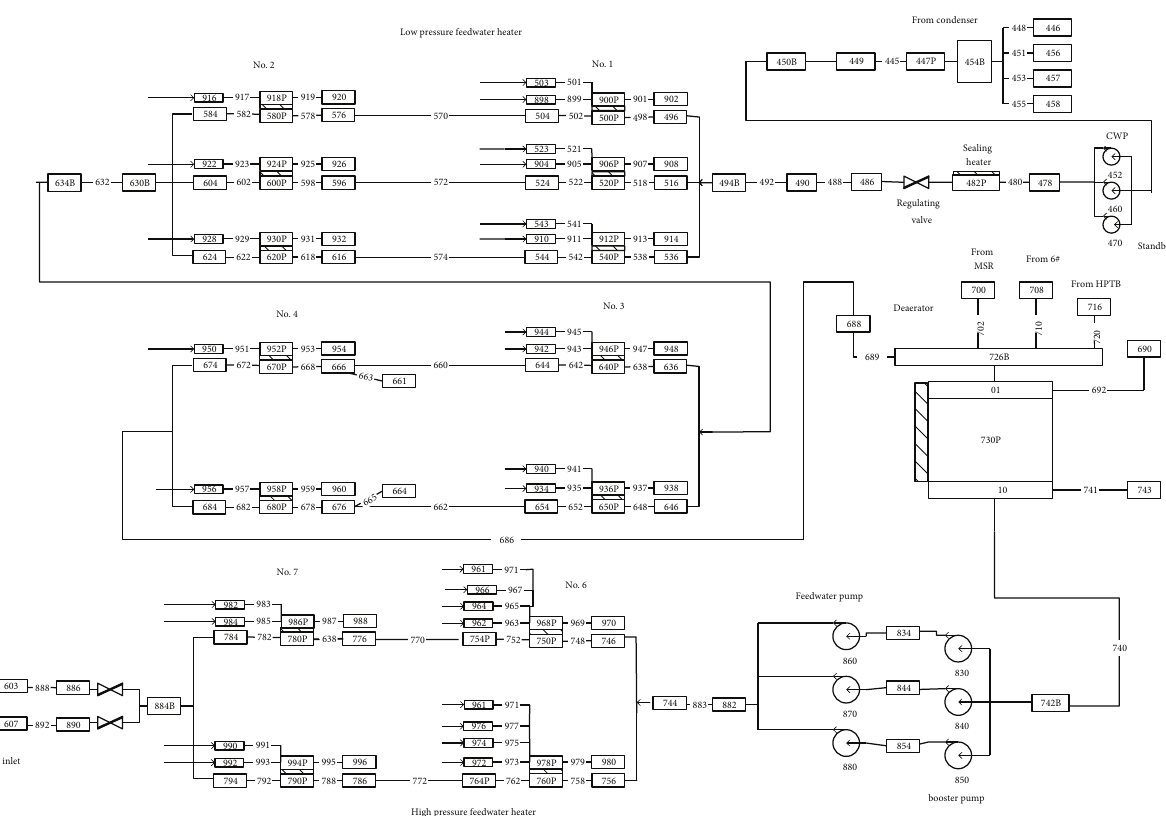
Figure 3: Nodal map of thermal-hydraulic system in conventional island (part